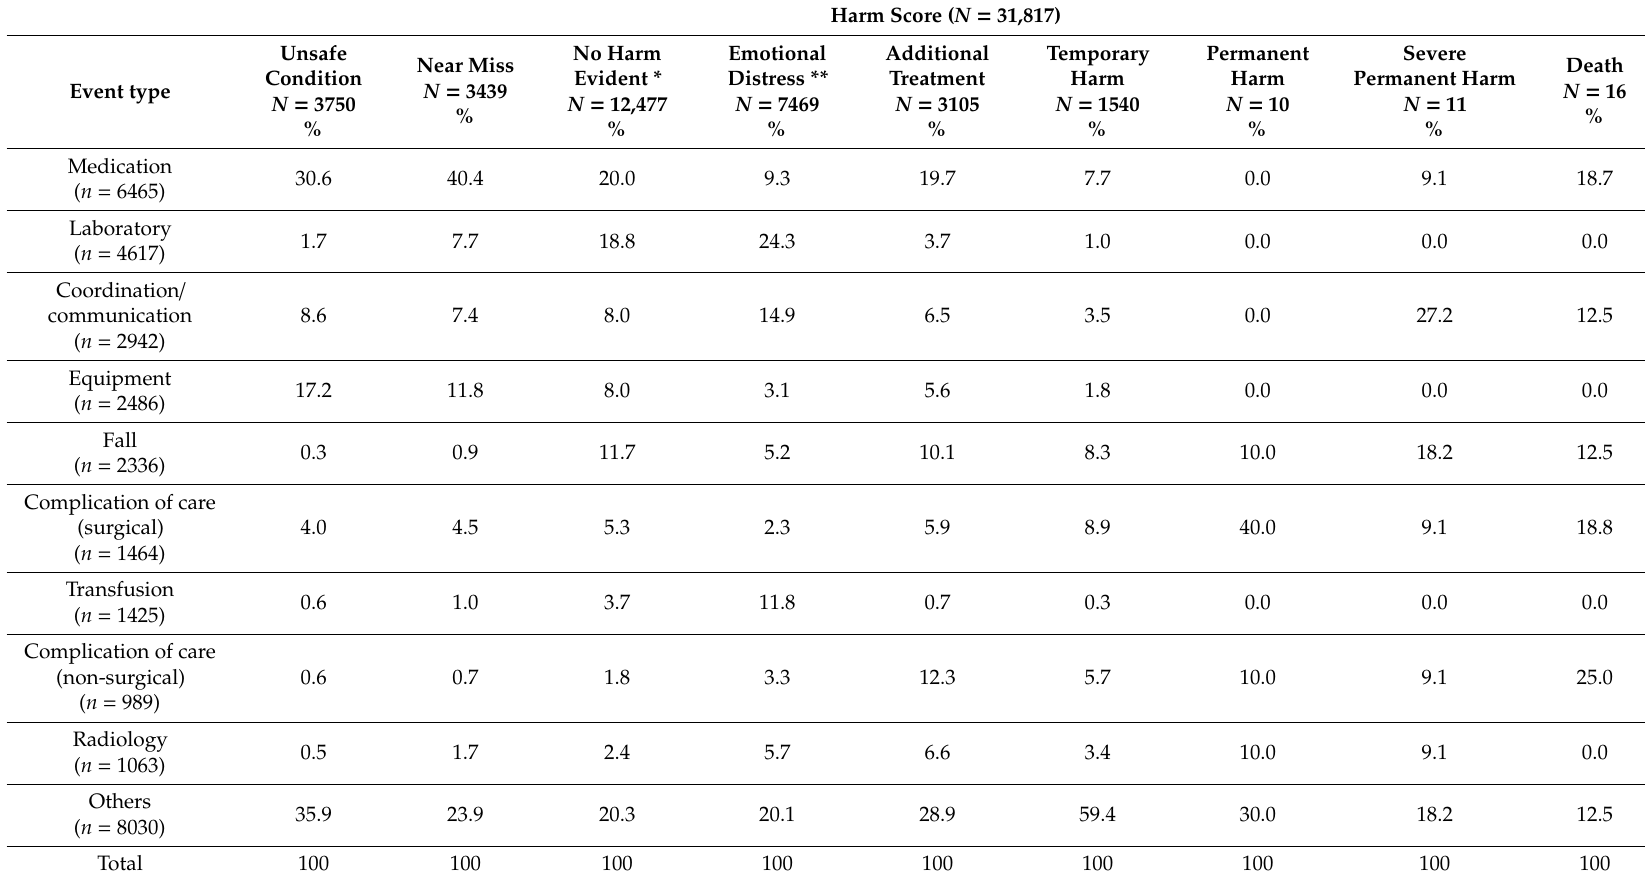
Table 4. Harm score and event type (percentage within harm